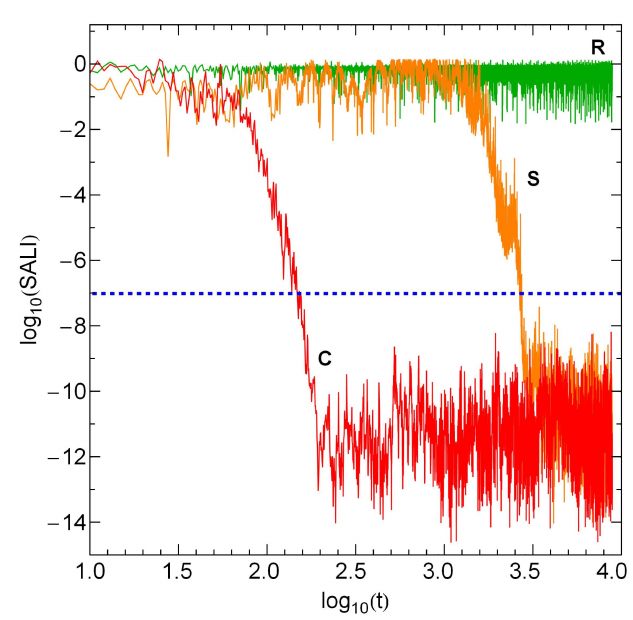
Fig. 2. Time-evolution of the SALI of a regular orbit (green color – R), a sticky orbit (orange color – S) and a chaotic orbit (red color – C) in our model for a time period of 10 4 time units. The horizontal, blue dashed line corresponds to the threshold value 10 (cid:0) 7 which separates regular from chaotic motion. The chaotic orbit needs only about 150 time units in order to cross the threshold, while the sticky orbit requires about 3000 time units so as to reveal its true chaotic